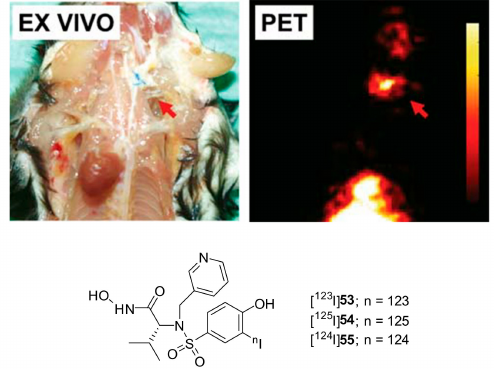
Figure 4. The site of the ligated left common carotid artery (left panel) and a corresponding whole-body coronal slice (0.4 mm thick) through a left carotid lesion (right panel) 4 weeks after ligation and a HC diet in an apoE − / − mouse. The intense uptake of the radiolabeled broad spectrum MMP inhibitor [ 124 I] 55 in the left carotid lesion (arrow) 30 min after intravenous injection is visible using high-resolution small animal PET. Reprinted with permission from ref [95] Copyright © Springer-Verlag